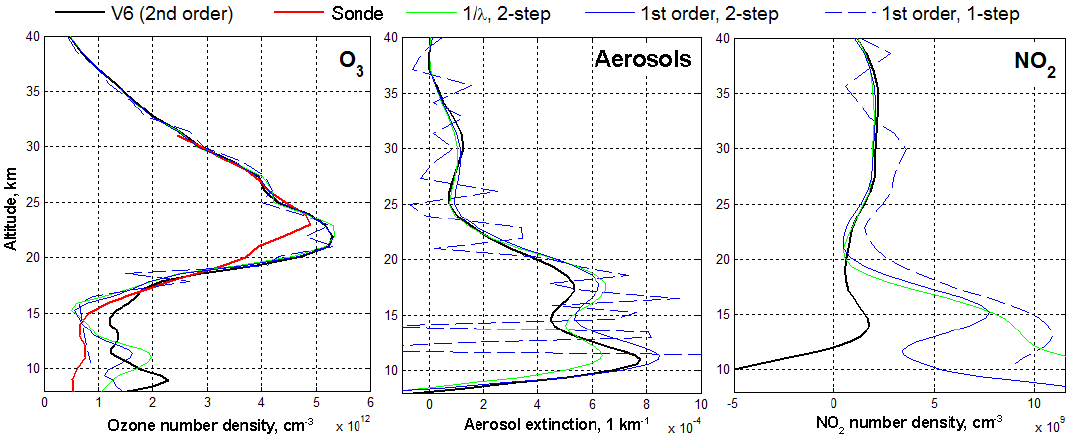
Figure 4. Sensitivity of ozone (left), aerosols (center), and NO 2 (right) profile retrievals to the aerosol model used in inversion. The considered aerosol extinction models are ∼ 1 /λ model (green line), first-degree polynomial in 1 /λ (blue lines), and second-degree polynomial (V6, black line). The results for the first-degree polynomial model are shown for both two-step and one-step inversion. The ozonesonde profile is shown by the red line in the left panel.